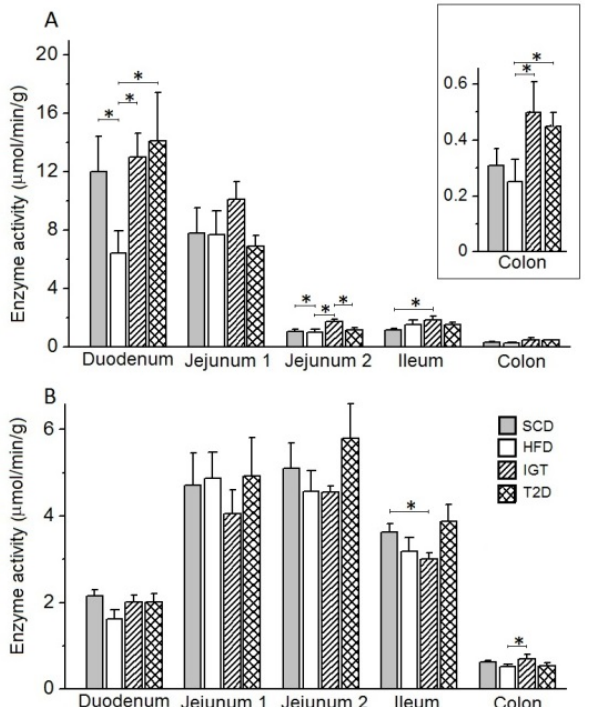
Figure 9. Activities of alkaline phosphatase and aminopeptidase N in the mucosa of various parts of the intestine in rats with type 2 diabetes (T2D), with impaired glucose tolerance (IGT) and in control groups: high-fat diet (HFD) and standard chow diet (SCD). ( A , B ) Jejunum 1 and 2 are proximal and distal halves of the jejunum, respectively. The T2D group ( n = 4), the IGT group ( n = 6), the HFD group ( n = 6) and the SCD group ( n = 6). Results are expressed as means ± the standard error of the mean (SEM). Student t -test: * p < 0.05.